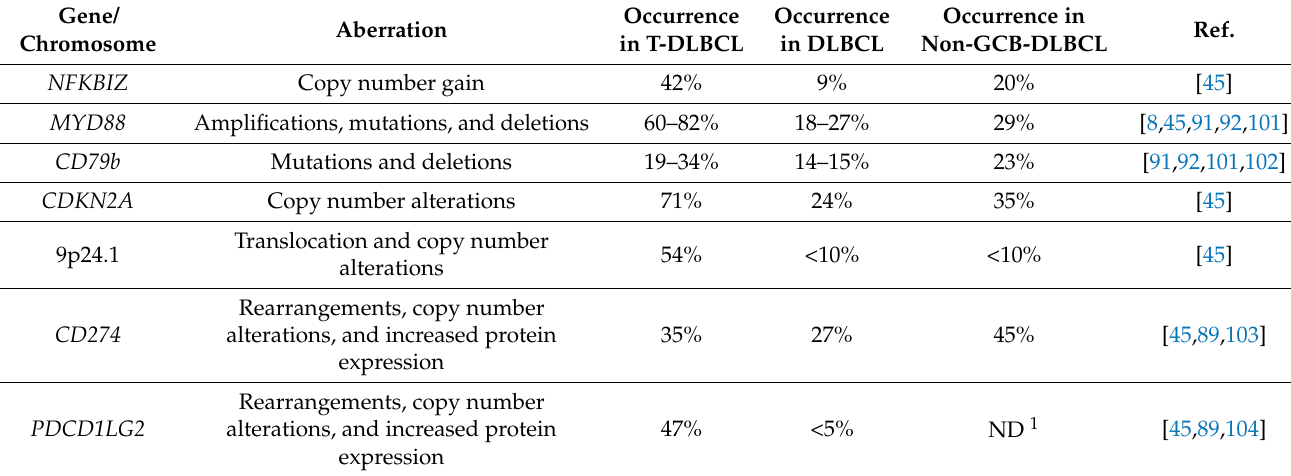
Table 4. Genetic alterations characteristic of T-DLBCL.